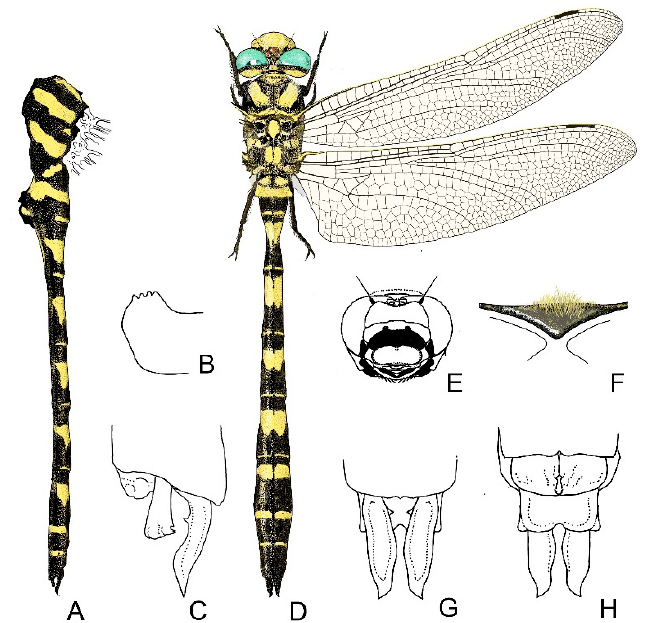
Figure 17. Cordulegaster amasina, re-description ♂ , (RMNH, Gert Jan van Pelt, RMNH.INS.974910, 31 July 2008, Turkey, Ankara, near Güvem, 40.5915° N, 32.6596° E, 1100 m a.s.l.): ( A ): habitus, lateral. ( B ): detailed latero-dorsalview on the hook of the inferior appendix. ( C ): appendages, lateral. ( D ): habitus, dorsal. ( E ): head, schematically. ( F ): occipital triangle, frontal. ( G ): appendages, dorsal. ( H ): appendages, ventral. Thorax (Figure 17A,D): anterior lobe of pronotum with yellow front edge; median lobe black with yellow dorsolateral ellipsoid patterns, two yellow middorsal dots; posterior lobe yellow interrupted by a middorsal black band; front of synthorax with broad big yellow antehumeral stripes, narrowing moderately towards pronotum leaving less than 20% black of antehumeral region; mesepimeron and metepimeron with broad yellow bands; metepisternum black with small yellow triangle near base of wings; metakatepisternum black; poststernum black; coxae, trochanter, femora, tibiae and tarsi black. Wings (Figure 17D) hyaline; costal veins yellow, other veins black; Pt black, Pt FW 3.6 × 0.4, HW 4.0 × 0.5; anal triangle 3-celled; membranula